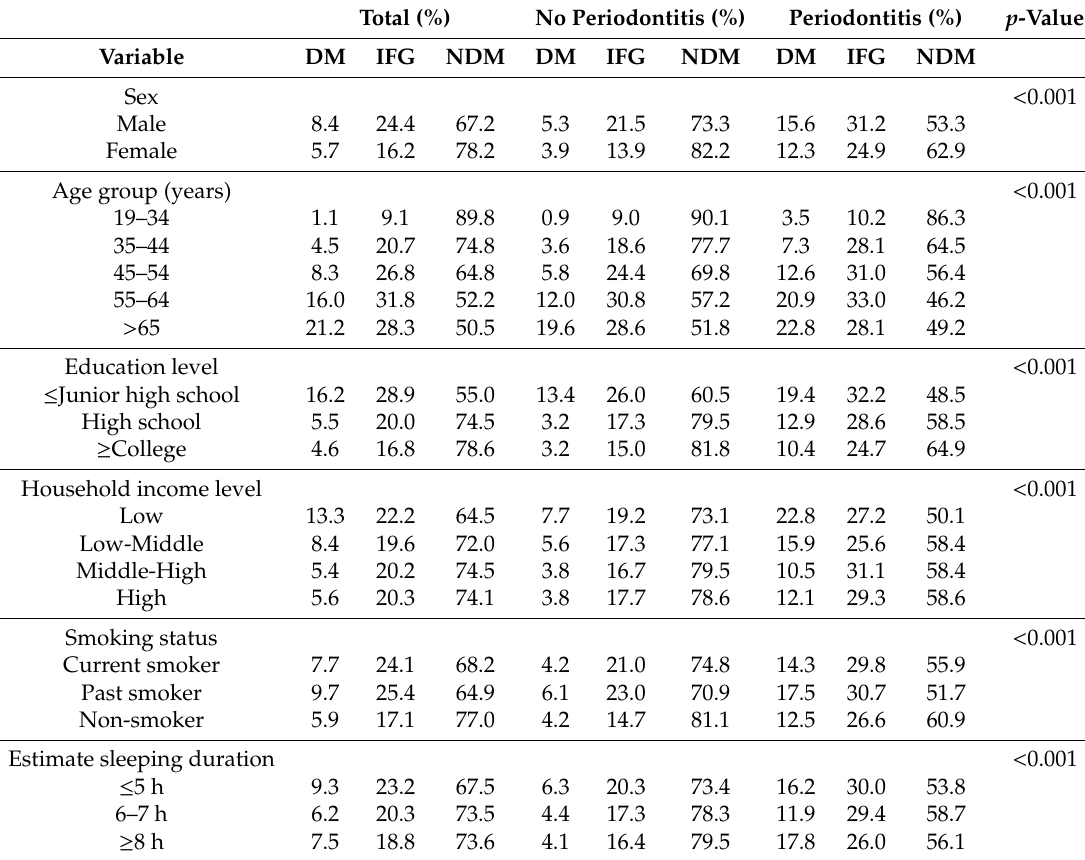
Table 1. The prevalence of periodontitis by demographic and socioeconomic parameters, smoking status, and sleeping duration. Total (%) No Periodontitis (%) Periodontitis (%) p -Value